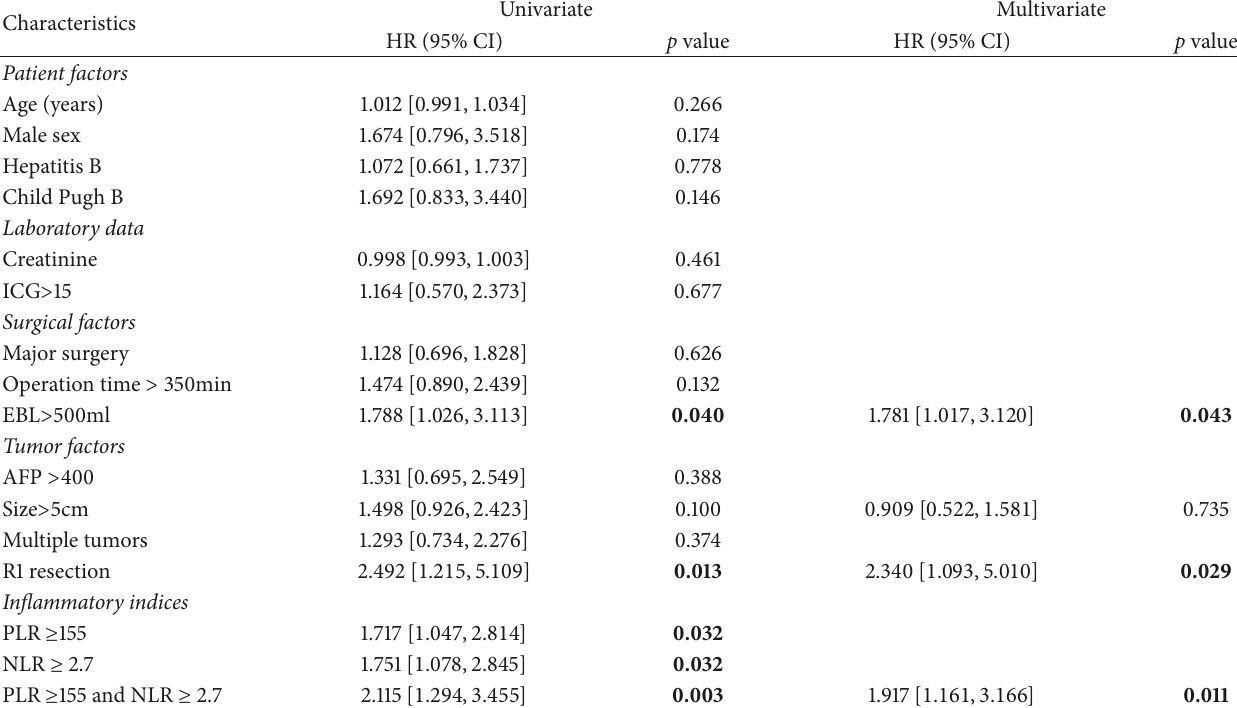
Table 3: Univariate and multivariate analysis of prognostic factors of recurrence free